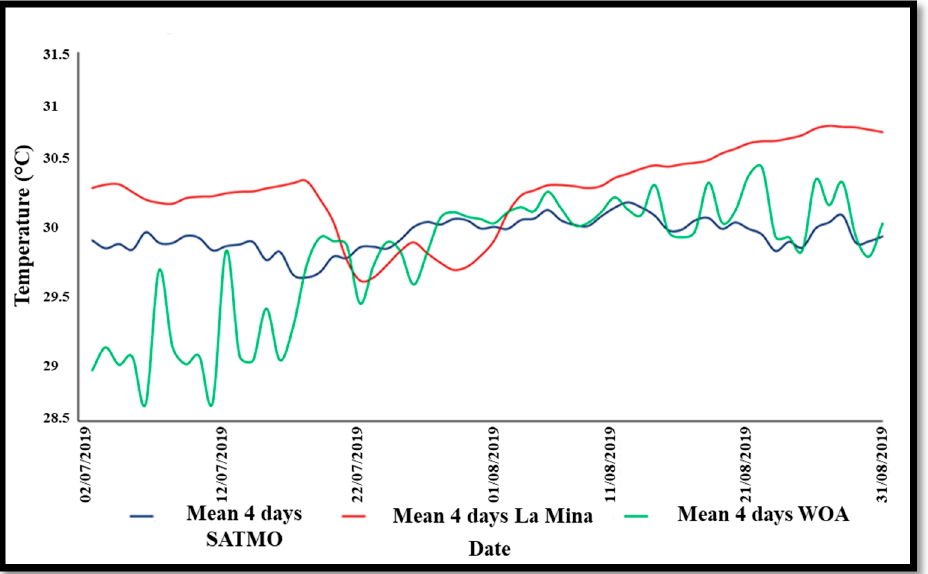
Figure 6 . Comparison of the 4-day averaged data for the three databases, SATMO, WOA and in situ at La Mina.